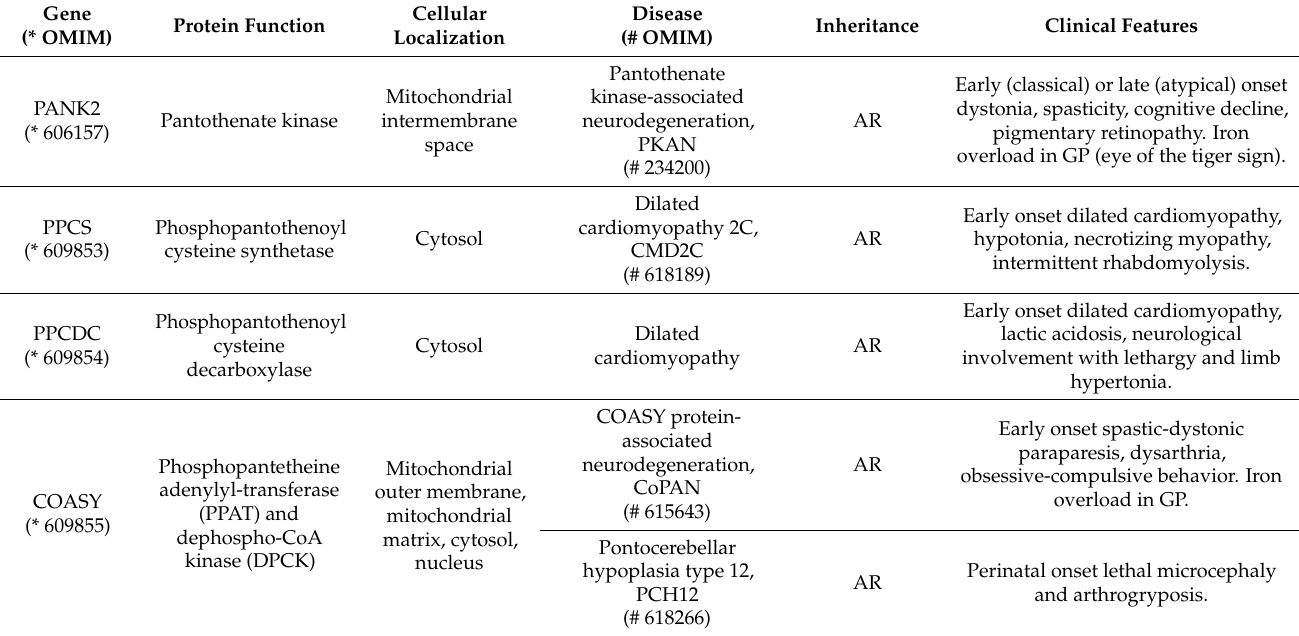
Table 1. Molecular and clinical features of inherited disorders of CoA